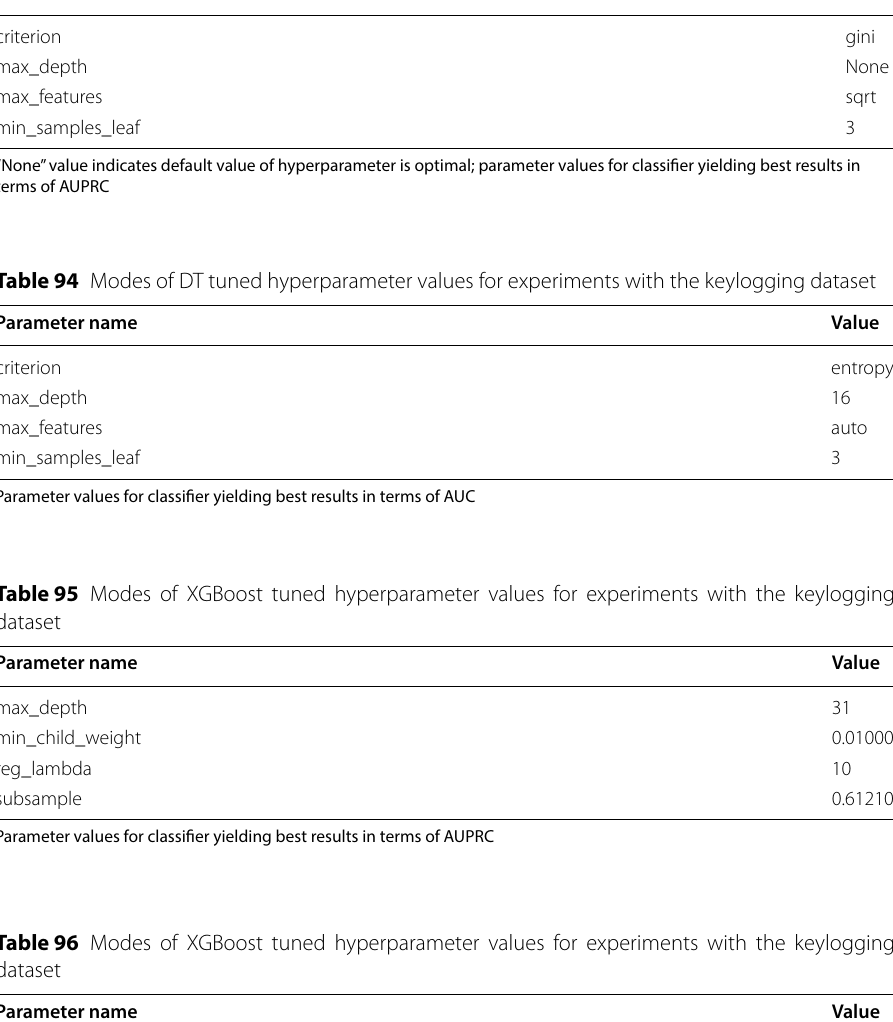
Table 93 Modes of DT tuned hyperparameter values for experiments with the keylogging dataset